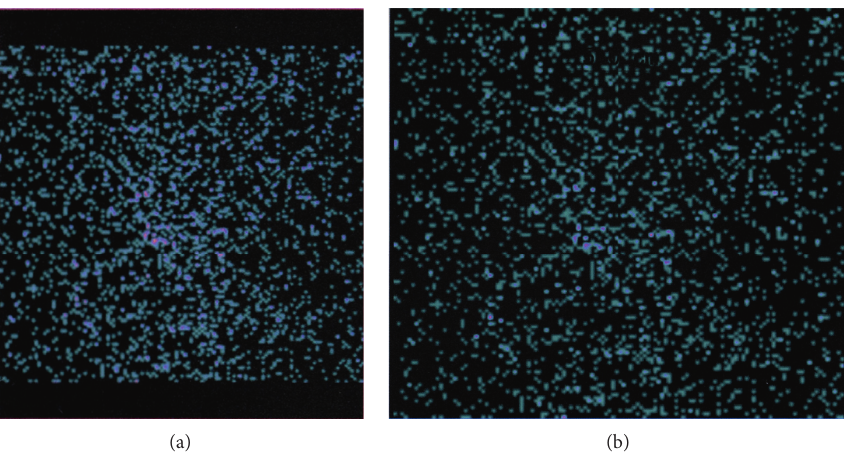
Figure 1: (a, b) The patient’s iodine thyroid scan with no uptake by the thyroid